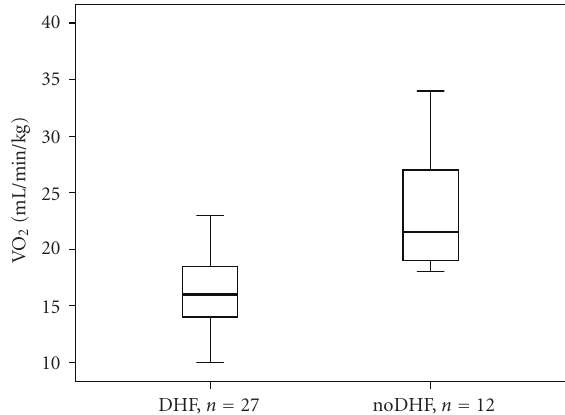
Figure 1: Relationship between peak oxygen consumption and groups defined by LV sti ff ness. Thick vertical lines represent mean and thin vertical lines represent standard deviation, P < .